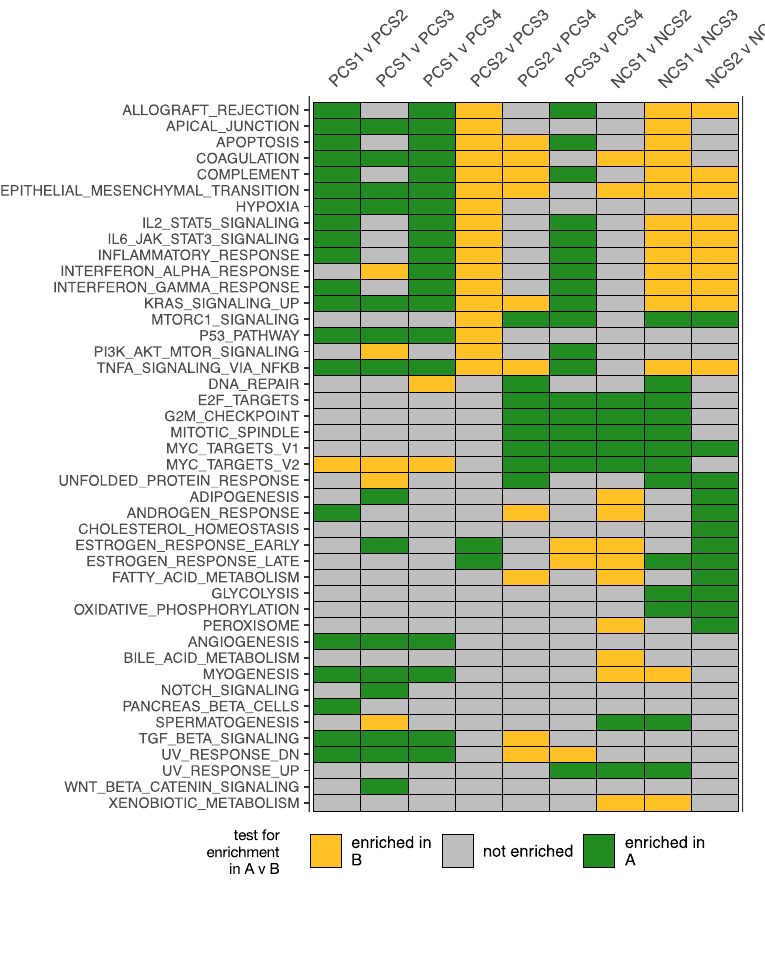
Fig. 3 Gene set enrichment by GSEA for pairs of BCCS subtypes. Enrichment for each Hallmark v7 gene set was tested between each pair of PCS1 – 4 and NCS1 – 3 and all three study cohorts using GSEA. A gene set was considered enriched between a pair of subtypes if the adjusted p - value was < 0.05 in all three cohorts. A GSEA test for enrichment in A versus (v) B reported the normalized enrichment score (NES); NES was positive if expression was enriched in A compared to B, and NES was negative if expression was enriched in B compared to A. A Hallmark gene set is omitted if it was not signi fi cantly enriched in any test. A tile is colored green (respectively, goldenrod) for the given pair and gene set, if in all three study cohorts, the adjusted p -value was < 0.05 and NES was positive (respectively, negative); a tile is gray if the adjusted p -value was ≥ 0.05 in some